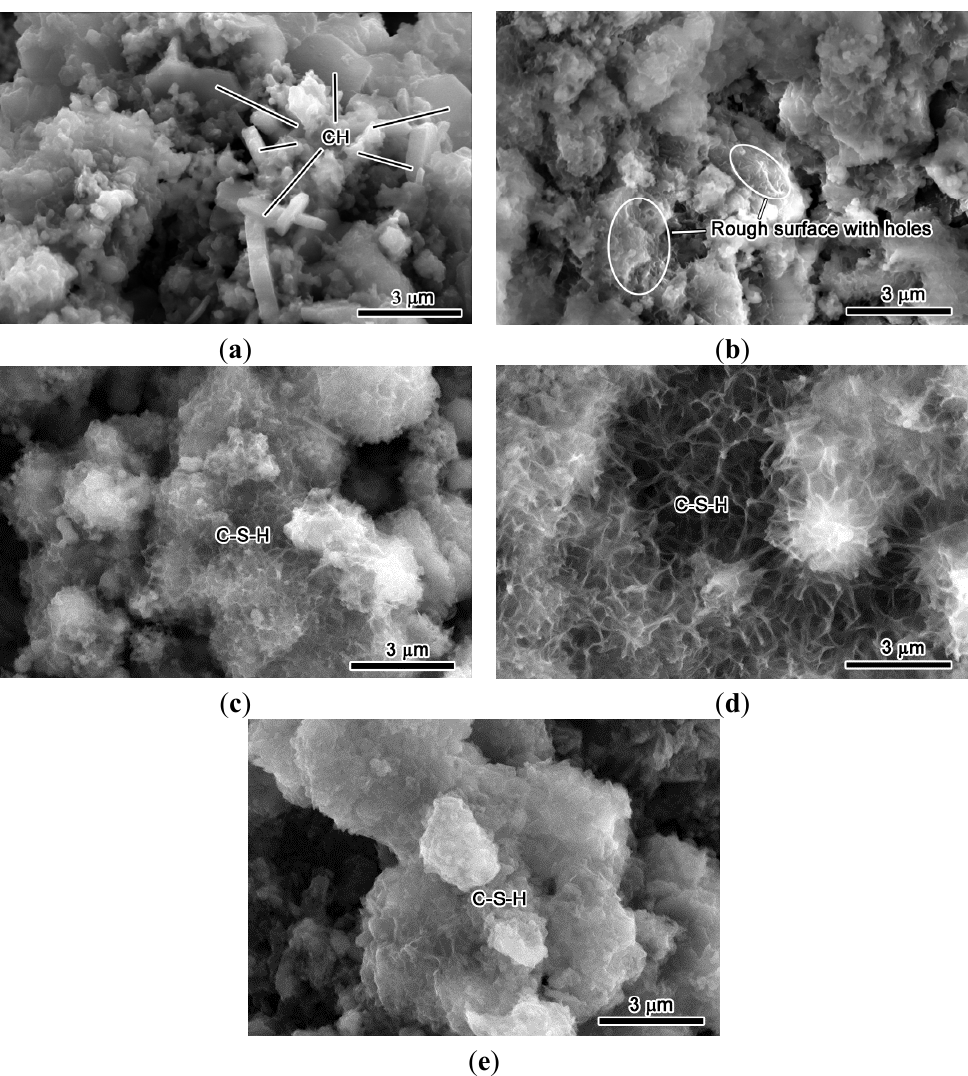
Figure 4. Environmental scanning electron microscopy (ESEM) observation of hydration process of UFP paste. The 1 ( a ), 3 ( b ), 7 ( c ), 14 ( d ) and 28-day ( e ) results of UFP paste are shown, respectively.